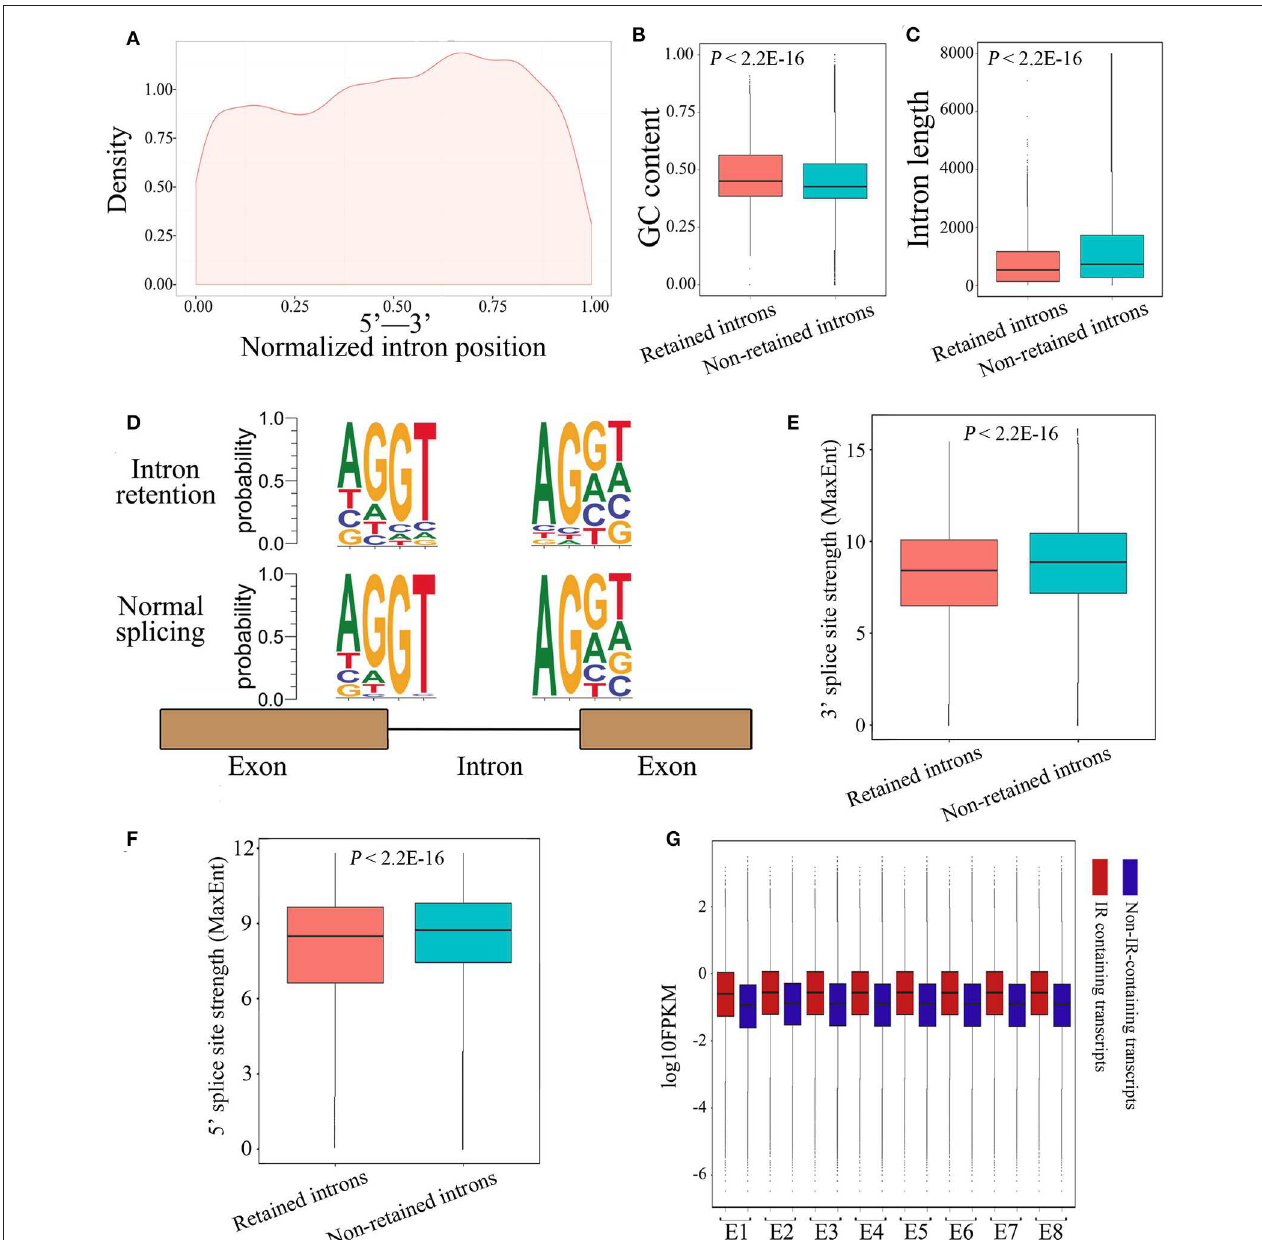
FIGURE 4 | Characterization of IR events in chicken embryos identified by Iso-Seq. (A) Graphic representation of the location of the retained introns within the gene body. Each location was represented as the ratio of intron start location to gene length. (B,C) Box plots representing comparison between retained introns and non-retained introns for their length (B) and GC content (C) . (D) The nucleotide sequence motifs near exon-intron junctions. Four nucleotides (two exonic and two intronic) of the 5 ′ donor splice sites and four nucleotides of the 3 ′ acceptor splice sites were analyzed. (E,F) Box plots represent the comparison between retained introns and non-retained introns for their 3 ′ (E) and 5 ′ (F) splice site strength. The 3 ′ and 5 ′ splice-sites strengths of introns were calculated using MaxEnt (Yeo and Burge, 2004) with default parameters. (G) Comparison of the expression levels between IR-containing transcripts and non-IR-containing transcripts during embryonic